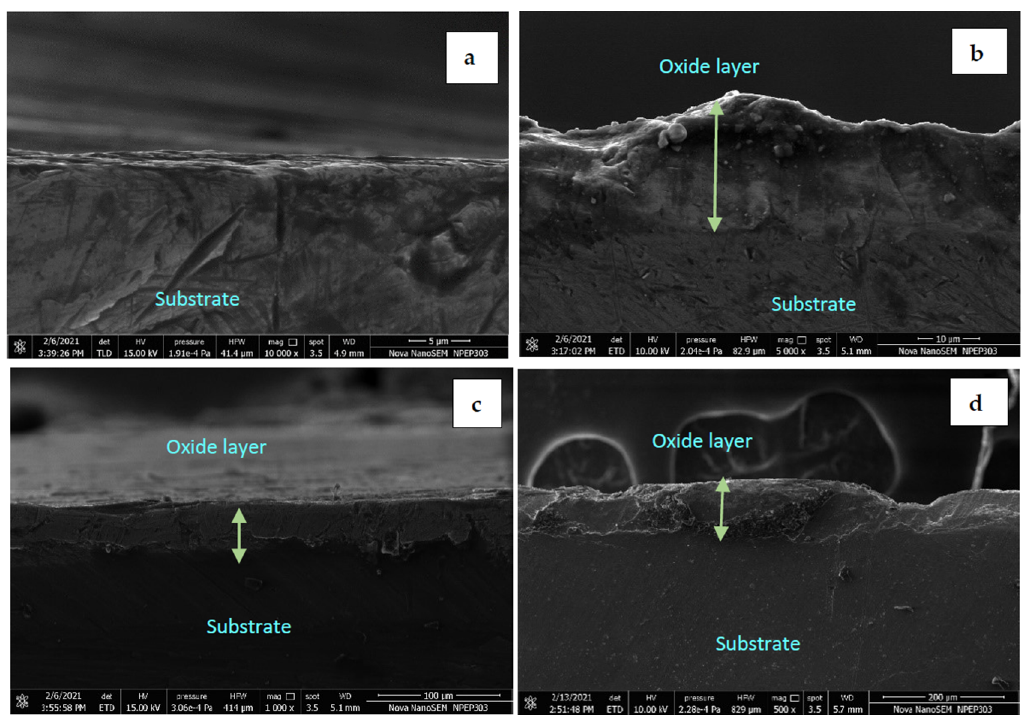
Figure 6. FESEM of the cross-section of the sample surface. ( a ) without forming an oxide layer. ( b ) At 197 V and 0.3 A. ( c ) At 197 V and 0.5 A. ( d ) At 197 V and 1 A. Table 4. The oxide layer thickness values as per variation in the distance between the electrodes. Sr. No. Distance between Electrodes in mm The Thickness of Oxide Layer (µm)